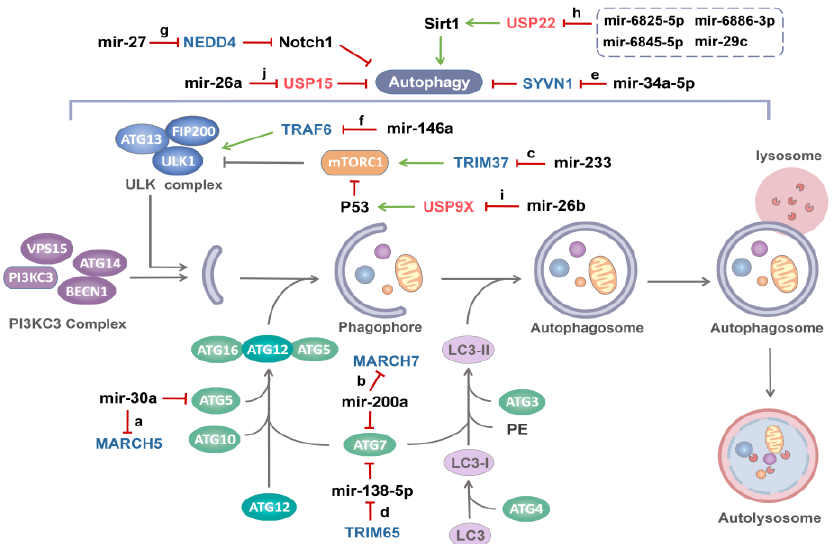
Figure 3. MiRNAs regulates autophagy by targeting E3 ubiquitin ligases or DUBs. Once receiving autophagy induction signals, ULK1 complex mediates the initiation of autophagy, and PI3KC3 com- plex participates in the nucleation of phagophore. Under the action of two ubiquitin-like systems, phagophore is continuously extended to form autophagosome, which eventually fused with lysosome to form autolysosome and the contents of the autolysosome are then degraded and exported back into the cytoplasm for reuse by the cell. (a) Mir-30a targets both MARCH5 and ATG5, MARCH5 RNA serves as a competing endogenous RNA (ceRNA) to regulate the expression of ATG5 by competing with ATG5 for mir-30a. (b) ATG7 and MARCH7 mRNA, as ceRNAs, regulate each other by competing for mir-200a. (c) Mir-233 increases autophagy by negatively targeting TRIM37, which promotes the mTORC1 pathway. (d) As a ubiquitin ligase of TNRC6, a component of miRISC, TRIM65 blocks the function of miRISC to achieve the effect of inhibiting mir-138-5p. However, ATG7 was upregulated by TRIM65 as a target of mir-138-5p. (e) Mir-34a-5p promotes autophagy by directly targeting SYVN1. (f) Mir-146a inhibits E3 ubiquitin ligase TRAF6, which has a positive regulatory effect on ULK1 protein through K63-linked ubiquitination. (g) Mir-27 targets NEDD4, the E3 ubiquitin ligase of Notch1, increasing Notch1 protein expression and decreasing autophagy. (h) Mir-6825-5p, mir-6845-5p, mir-6886-3p and mir-29c can directly target USP22, the DUB of Sirt1, and ultimately suppress Sirt1-mediated autophagy. (i) Mir-26b negatively targets USP9X, a DUB of p53, and affects autophagy by inducing p53 degradation. (j) Mir-26a negatively targets USP15, which inhibits autophagy.